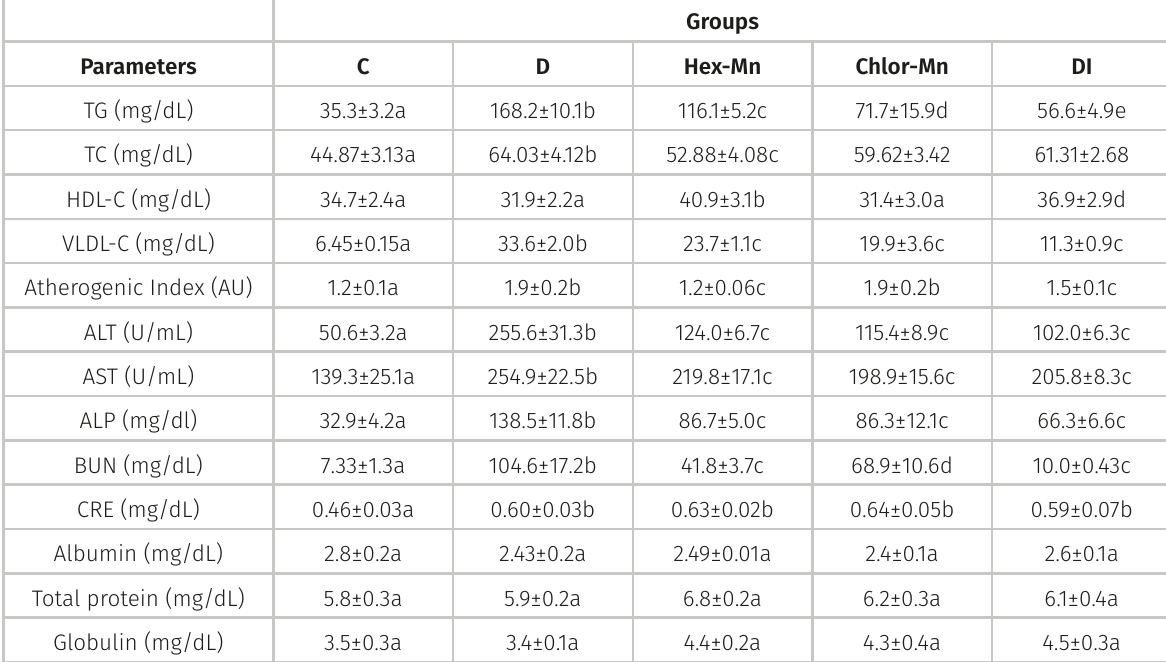
Table III. Effect of Hex-Mn and Chlor-Mn fractions on biochemical and lipid profile in control and diabetic treated for 21